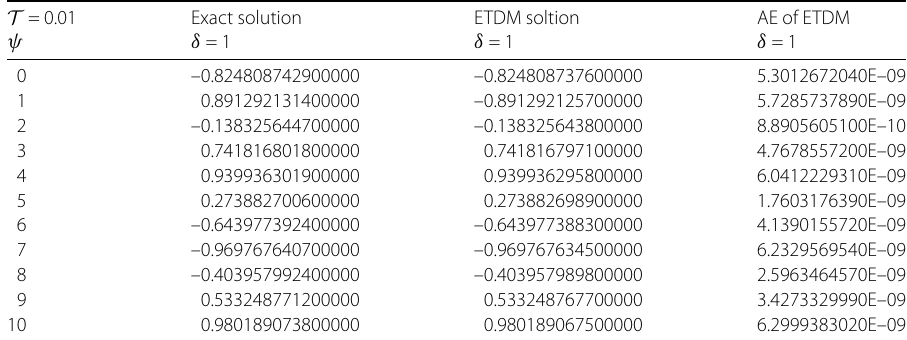
Table 1 μ ( ψ , ζ , T ) Comparison of Exact soltion, ETDM and ETDM Error of example 1 at ρ = 1 T = 0.01